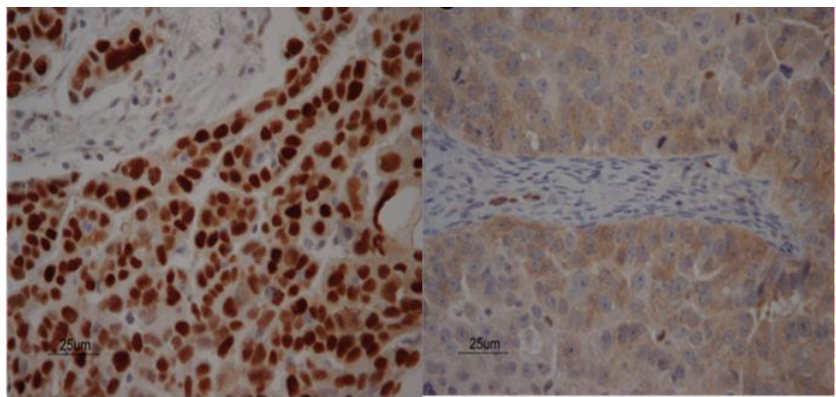
Figure 1. Tissue p53 staining. Two examples of immunohistochemical localization of p53 expression in patients with advanced stage ovarian cancer. Staining of sporadic nuclei with p53 antibody is seen in the stroma in both figures, acting as internal control. The p53 expression showed strong nuclear staining in patient 5 with a TP53 p.K132R mutation (left figure) and cytoplasmic staining in patient 6 without a TP53 mutation (right figure).